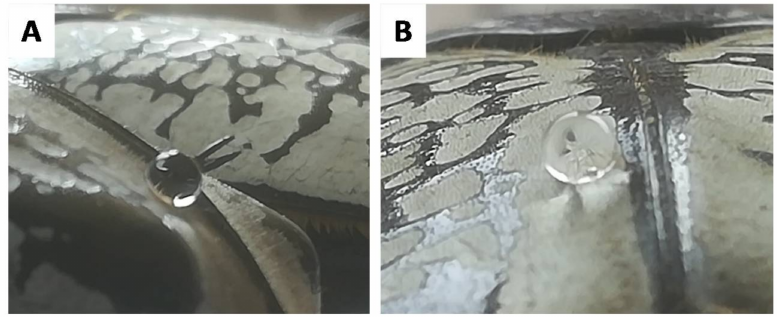
Figure 3. Water droplet deposited on the white part of a G. orientalis elytron. ( A ) Side view and ( B ) back view.